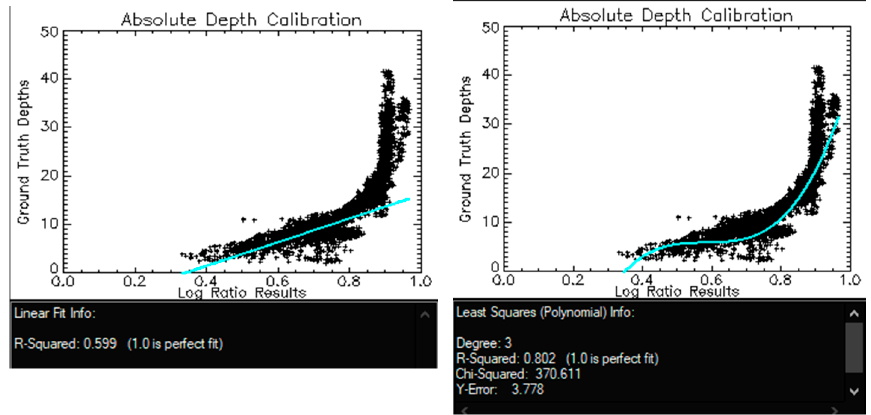
Figure A8. From 7 January 2014.